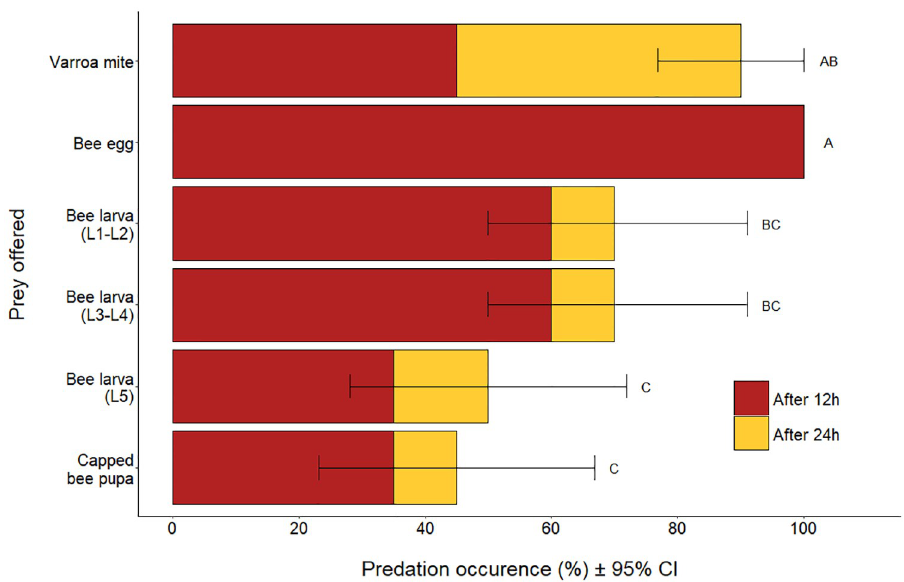
Fig 1. Occurrence of predation of Varroa destructor (female adults) and five different honey bee brood stages by the predatory mite Stratiolaelaps scimitus , after 12h and 24h of confinement in experimental arenas. Each arena (n = 20 per type of prey) contained 20 starved female predatory mites and a single prey. Error bars show the 95% confidence intervals after 24 h. Different letters represent significant differences (p � 0.05, Fisher’s exact test followed by pairwise comparisons with Benjamini-Hochberg adjustment) in predation occurrence at the end of the test. https://doi.org/10.1371/journal.pone.0208812.g001 prey (Fig 2). At the end of the experiment, an average of 15 ± 3 (mean ± SD) predatory mites were still alive in each arena.